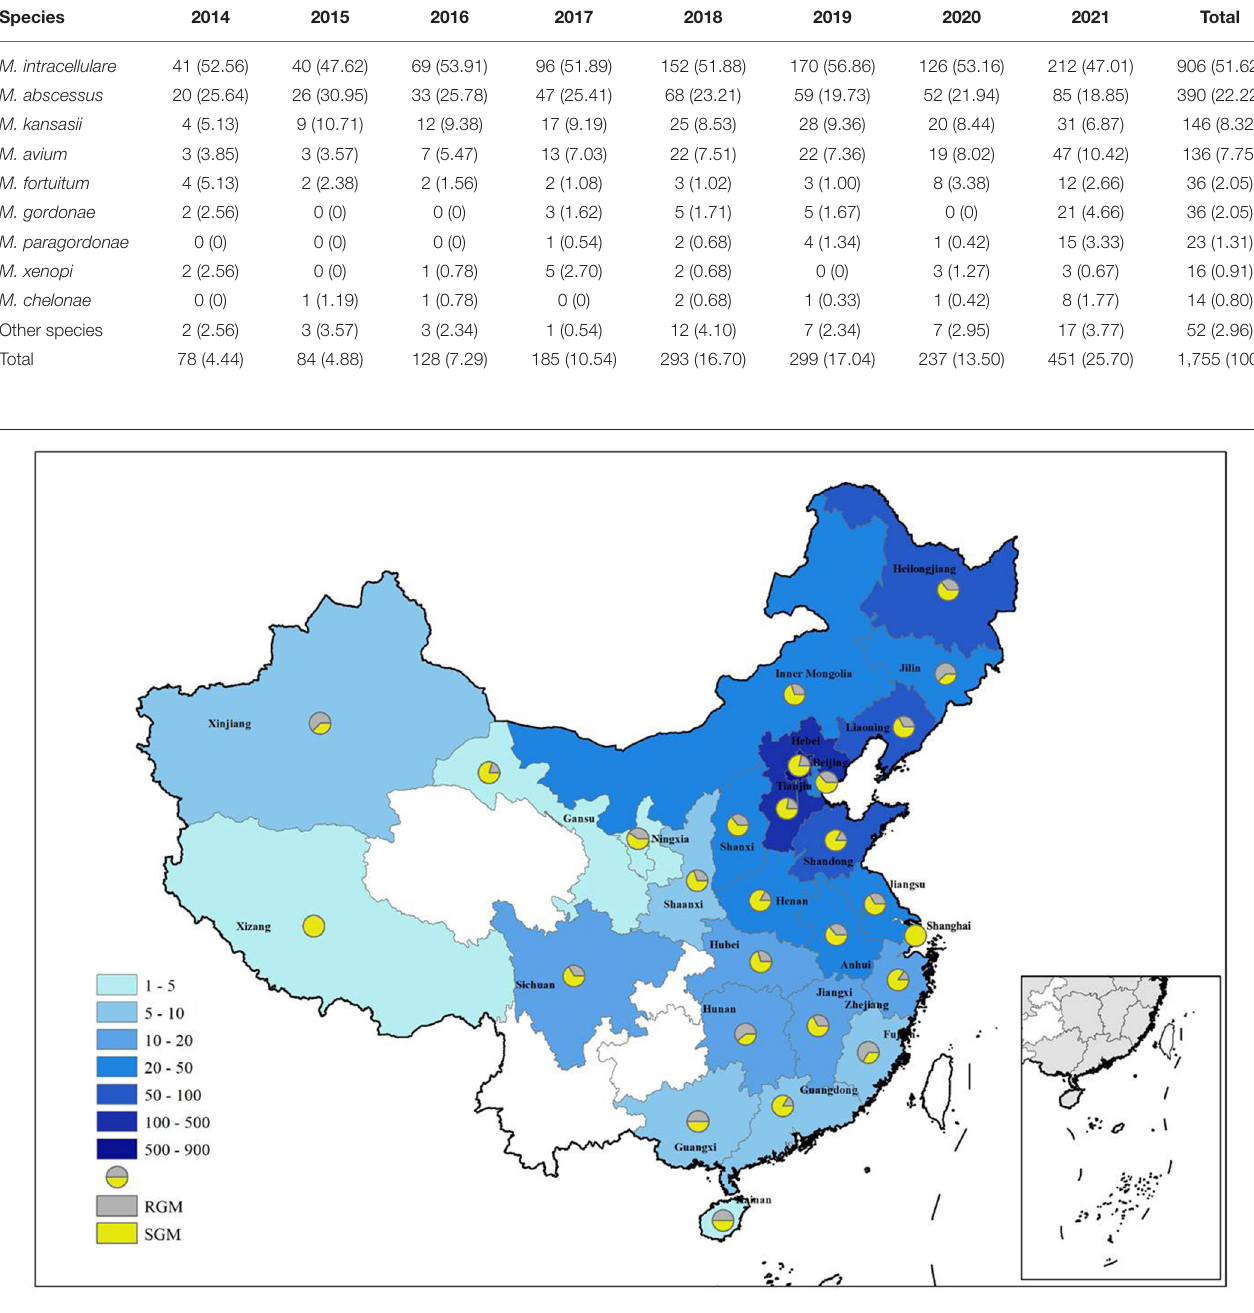
could not identify the newly discovered NTM species and non- mycobacteria pathogens (31, 32). Target DNA sequencing, such as 16S rRNA , rpoB , hsp65 , and ITS, not only could identify the NTM strains to the species level, but also could distinguish NTM from non-mycobacterial but related genera, such as Gordonia